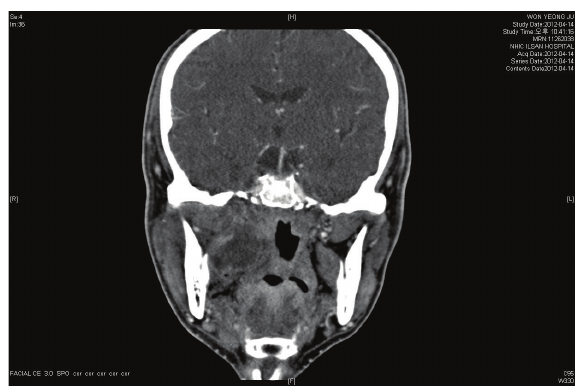
Figure 1: On CT images, an abscess pocket had di ff used from the right pterygomandibular area to the right cavernous sinus area.